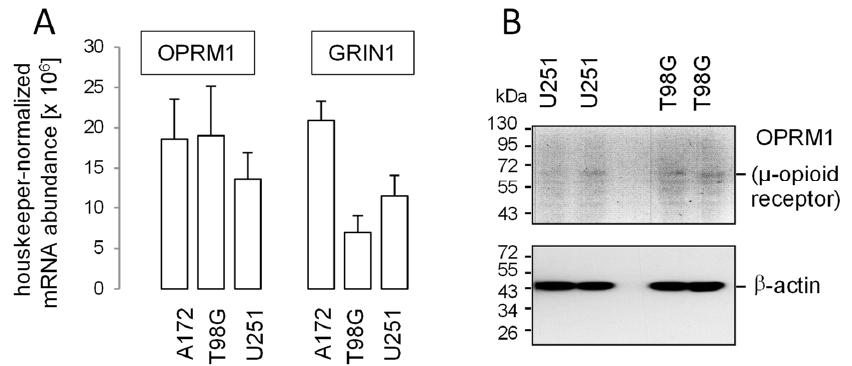
Figure 2. Abundance of µ -opioid (OPRM1) and N -methyl- d -aspartate (NMDA) receptors (GRIN1) in human glioblastoma cell lines. ( A ) Mean (SE, n = 3) housekeeper-normalized abundances of OPRM1 ( left ) and GRIN1 ( right ) mRNA in A172, T98G, and U251 cells. ( B ) Immunoblots from total cell lysates of U251 (left) and T98G ( right ) cells separated by SDS-PAGE and probed against OPRM1 (µ-opioid receptor, upper blot) and for loading control against β -actin (lower blot) Human glioblastoma cell lines T98G, A172 and U87MG (see below) were obtained from the American Type Culture Collection (ATCC, Bethesda, MD, USA) and grown in 10% fetal bovine serum (FBS)-supplemented RPMI-1640 medium. The U251 cells were a kind gift from Dr. Luiz O. Penalva (Graduate School of Biomedical Sciences, UT Health San Antonio, Texas) and grown in Dulbecco’s modified Eagle’s medium containing 4500 mg glucose / l and 10% FBS. Total RNA was isolated using the NucleoSpin RNA Kit (Macherey-Nagel, Düren, Germany). OPRM1-, GRIN1- and housekeeper β -actin (ACTB)-, pyruvate dehydrogenase beta (PDHB)-, and glyceraldehyde-3-phosphate dehydrogenase (GAPDH)-specific fragments were amplified by the use of SYBR Green-based quantitative real-time PCR (QuantiTect Primer Assay QT00001512, QT00082089, QT00095431, QT00031227, and QT01192646, QIAGEN, Venlo, Netherlands, and1StepRTqPCRGreenROXLKit, highQu, Kraichtal, Germany)inaRocheLightCycler ® 480 (Roche, Mannheim, Germany). Abundances of the individual mRNAs were normalized to the geometrical mean of the three housekeeper mRNAs. For western blotting, cells were lysed in a bu ff er (containing in mM: 50 N-2-hydroxyethylpiperazine-N-2-ethanesulfonic acid (HEPES) pH 7.5, 150 NaCl, 1 ethylenediaminetetraacetic acid (EDTA), 10 sodium pyrophosphate, 10 NaF, 2 Na 3 VO 4 , 1 phenylmethylsulfonylfluoride (PMSF) additionally containing 1% triton X-100, 5 µ g / mL aprotinin, 5 µ g / mL leupeptin, and 3 µ g / mL pepstatin) and separated by SDS-PAGE under reducing condition. Blots were blocked in tris(hydroxymethyl)aminomethane-bu ff ered saline (TBS) containing 0.05% Tween 20 and 5% non-fat dry milk for 1 h at room temperature. The membrane was incubated overnight at 4 ◦ C and for 1 h at room temperature with recombinant anti- µ -opioid receptor antibody [UMB3] [96] (ab227067, Abcam, Berlin, Germany, 1:500) and anti- β -actin (1:20,000, clone AC-74, #A2228, Sigma-Aldrich, Deisenhofen, Germany), respectively. Antibody binding was detected with a horseradish peroxidase-linked goat anti-rabbit IgG antibody or anti-mouse IgG antibody (Cell Signaling # 7074 and # 7076, respectively; 1:1000–1:2000) incubated for 1 h at room temperature (all antibody dilutions in TBS-Tween / 5% milk) and enhanced chemiluminescence (ECL western blotting analysis system, GE Healthcare / Amersham-Biosciences, Freiburg,